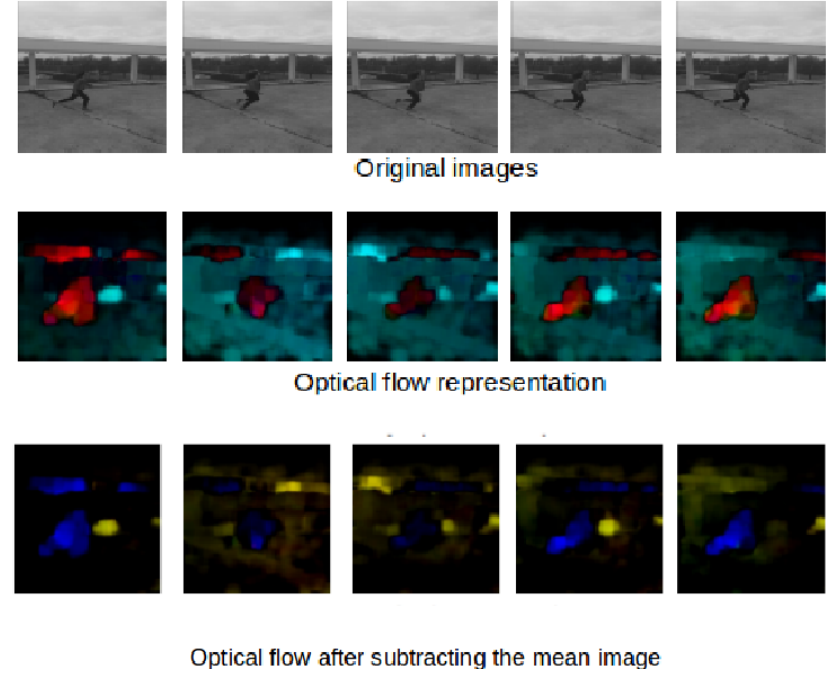
Figure 4. Subtraction of mean optical flow.